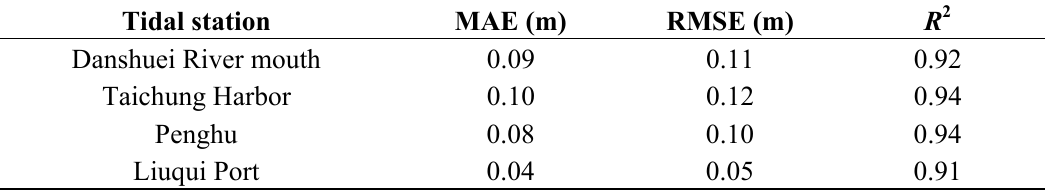
Table 1. Statistical error of the difference between the computed and observed water